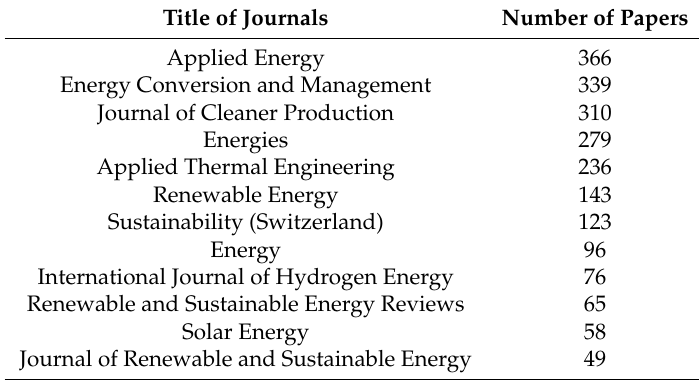
Table 3. Titles of journals (which published at least 15 relevant papers) and number of papers in each of them in the subject area of energy in Scopus from the year 2000 to October